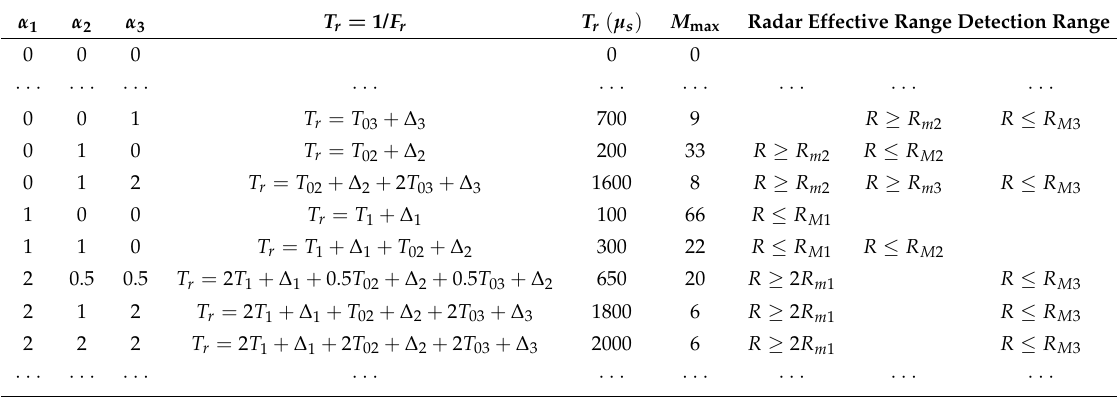
Table 3. Relationship between emission period and waveform